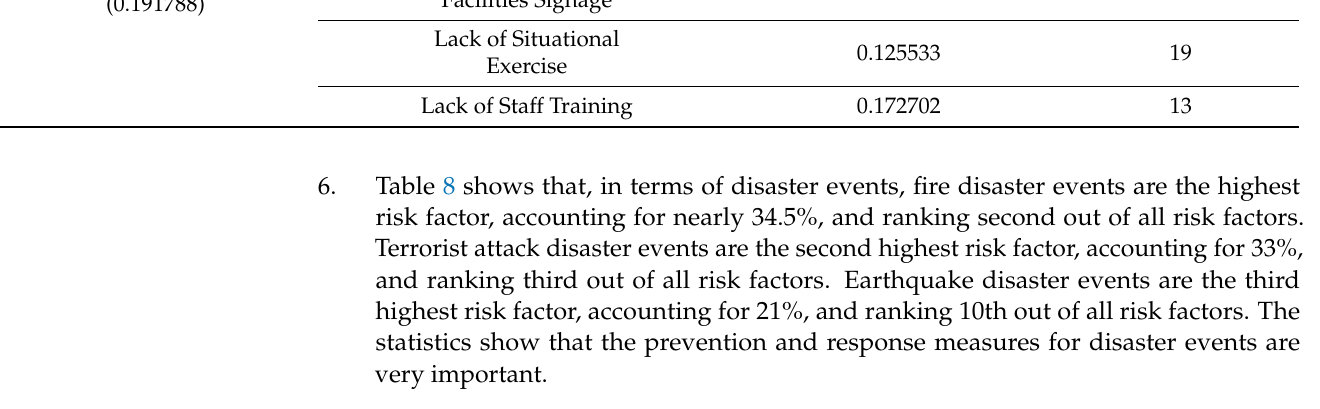
Table 8. Weighting values for the effects of disaster